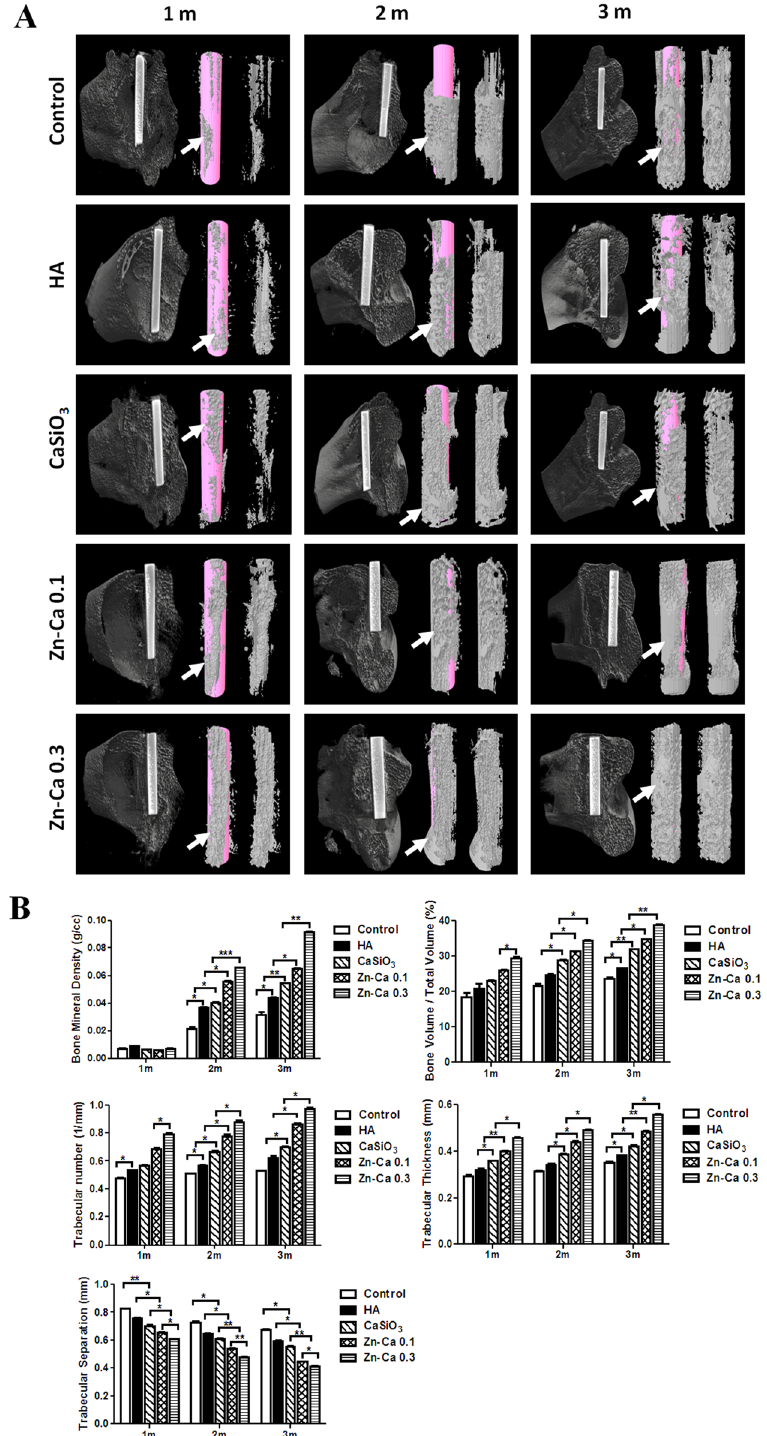
Figure 5. 3-D micro-CT analysis for the assessment of newly formed bone tissue on the surface of Ti-6Al-4V and on hydroxyapatite (HA), CaSiO Zn-Ca 0.1 and Zn-Ca 0.3 coatings (pink) at 1, 2, and 3 months post-implantation. White arrows indicate new bone formation. ( B ) Quantitative results of implant osseointegration and peri-implant microstructural parameters, such as bone mineral density, bone volume/total volume of bone, trabecular number, trabecular thickness and trabecular separation, on the surface obtained by micro-CT assessment 1, 2, and 3 months after implant insertion. All data are represented as the mean ± SD (n = 3). * p < 0.05, ** p < 0.01, *** p <